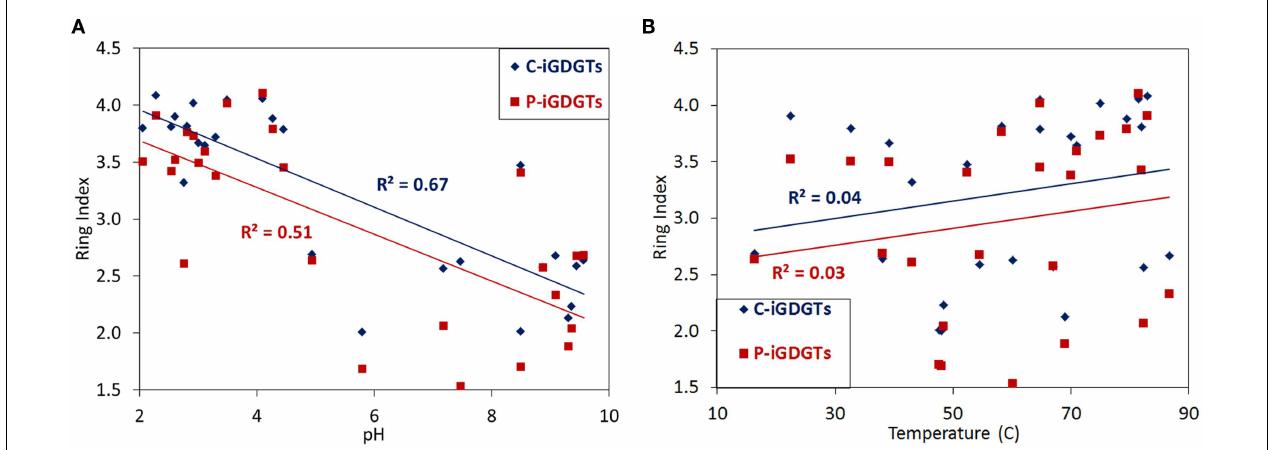
FIGURE 3 | C-iGDGT and P-iGDGT ring indices plotted as a function of spring pH (A) and spring temperature (B).